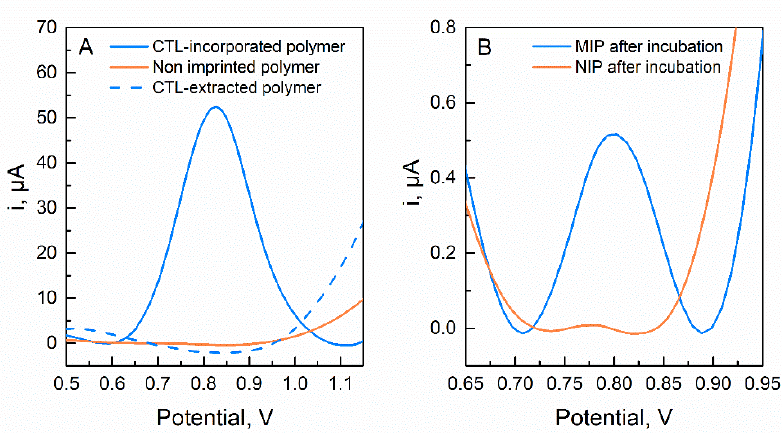
Figure 4. SWV voltammograms in 0.1 M of phosphate buffer (pH = 7) obtained after ( A ) MIP (0.5 mmol L − 1 CTL, 1.5 mmol L − 1 AHBA) and NIP (1.5 mmol L − 1 AHBA) polymerization and extraction of CTL molecules; ( B ) MIP and NIP sensing responses after 15 min of 1 µ mol L − 1 CTL